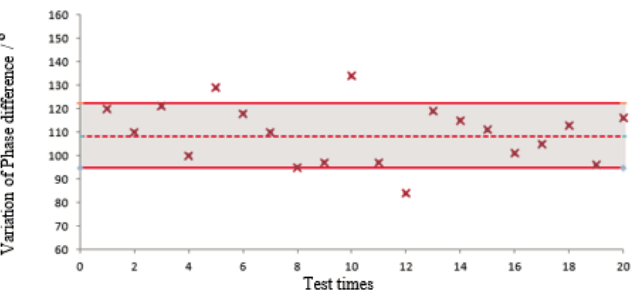
Figure 10. Multiple measurement results